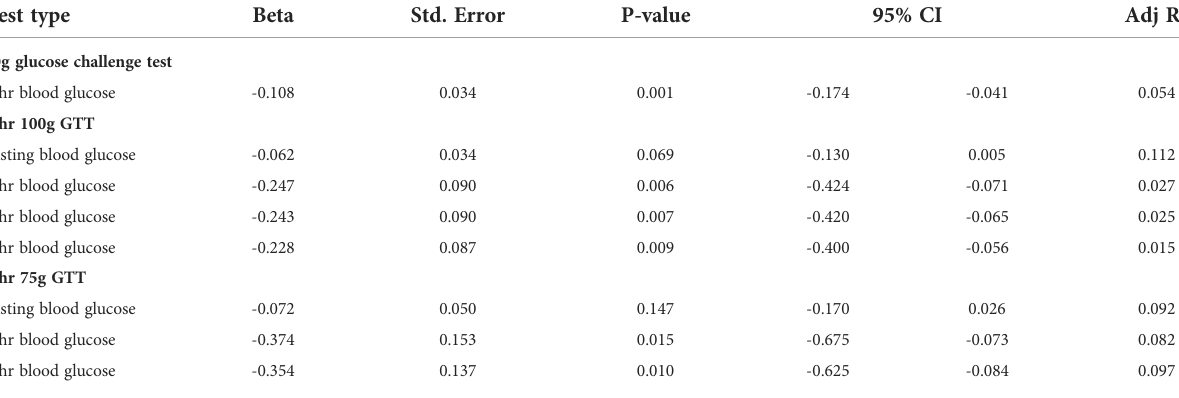
Adjusted for covariates: maternal age, race/ethnicity, smoking status, early pregnancy body mass index, rate of gestational weight gain, energy intake, nausea and vomiting of pregnancy (PUQE score), study site. AHEI, Alternative Healthy Eating Index; GTT, glucose tolerance test.